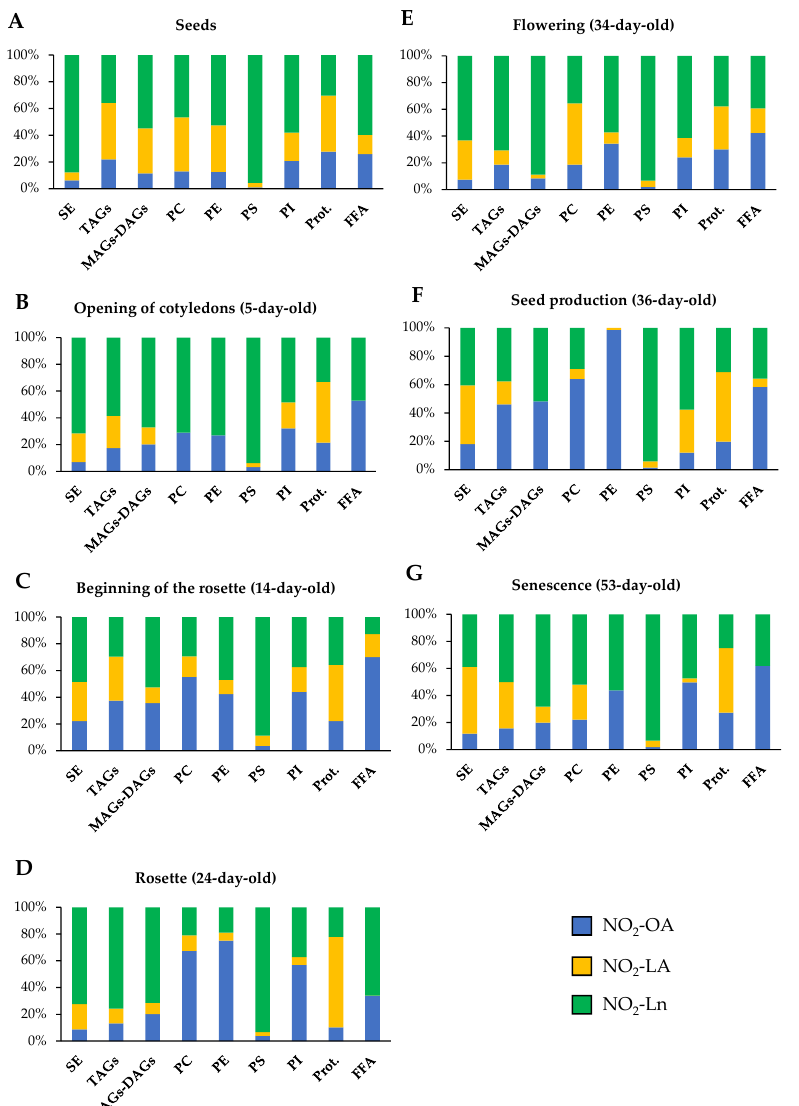
Figure 6. NO 2 -FAs relative abundance in the different storage biomolecules in each Arabidopsis development stage. This figure shows the relative concentration (expressed as a percentage) of each NO 2 -FA in the different lipid and protein storages present in seeds ( A ) and in the 5- ( B ), 14- ( C ), 24- ( D ), 34- ( E ), 36- ( F ), and 53-day-old plants ( G ). The 100% represents the sum of the total NO 2 -OA, NO 2 -LA, and NO 2 -Ln content in each of the biomolecules storages studied for each stage of devel- opment.